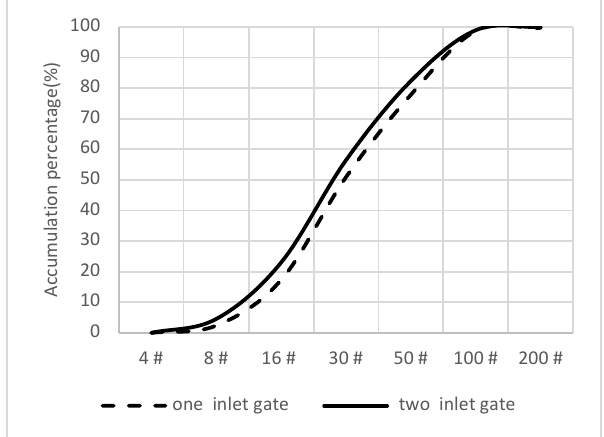
Fig. 9. Comparing Collected particles percentage in hydrocyclone with one and two inlet